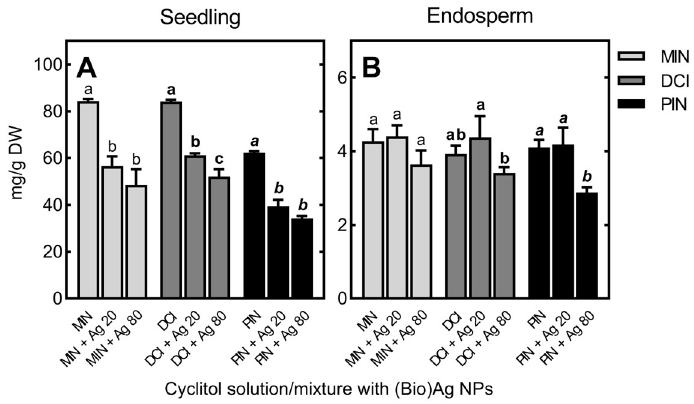
Figure 3. The concentrations of myo -inositol (MIN), D - chiro -inositol (DCI) and D -pinitol (PIN) in seedlings ( A ) and endosperm ( B ) of wheat ( Triticum aestivum L. cv. Ostka Strzelecka) germinating for 3 days in solutions of free cyclitols (at 100 mM each) or their mixtures with (Bio)Ag NPs at 20 and 80 mg/L (Ag 20 and Ag 80, respectively). Values are means ( n = 3) + SD. Bars with the same letters (a–c, a – c , a – c ) were not significantly ( p < 0.05) different after ANOVA test and Tukey’s post hoc corrections.